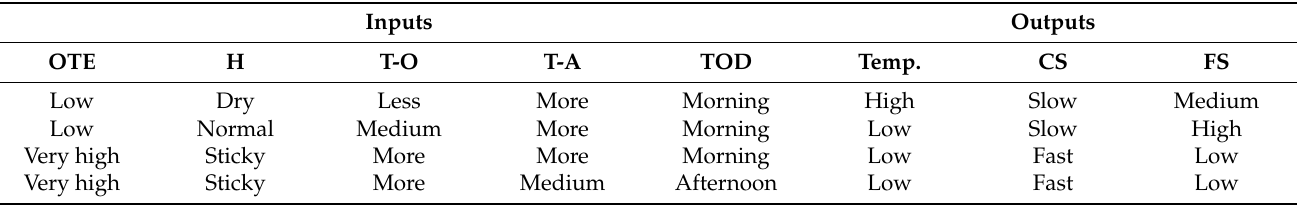
Table 2. Rules for truth membership of neutrosophic logic represented as (T-O, T-A).